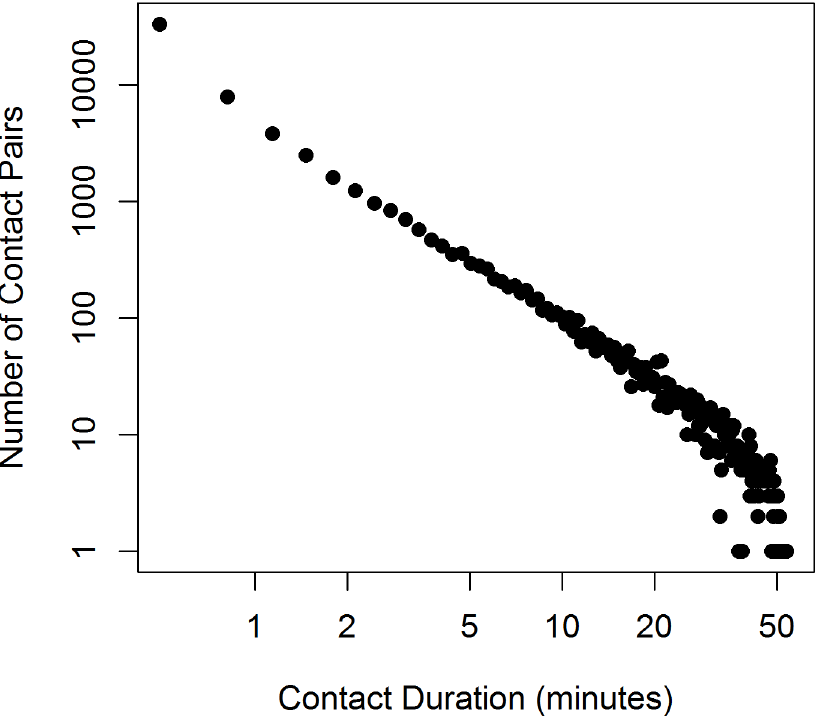
Fig 3. Frequency of contact pairs by contact duration (in minutes) on a log-log